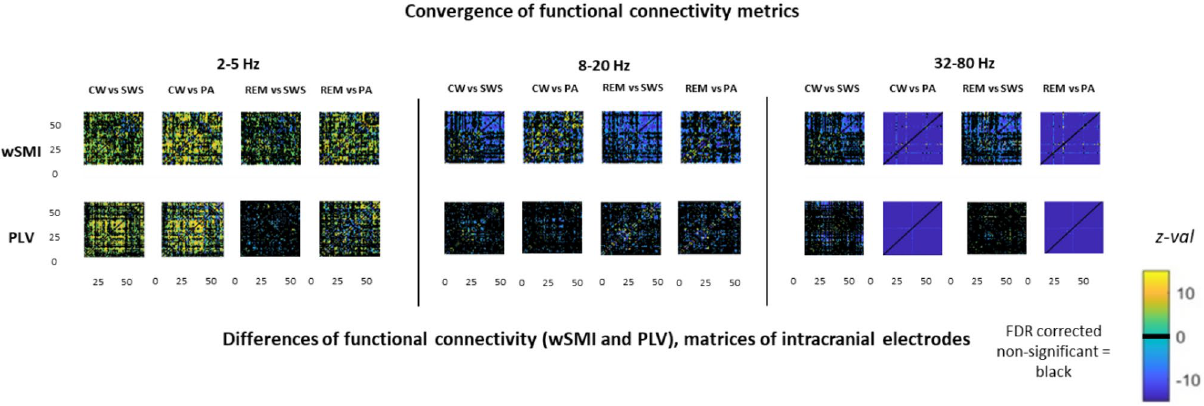
Figure 4. Example functional connectivity matrices estimated by wSMI and PLV (patient 1 of the second experiment). CW conscious wakefulness, SWS N3 slow wave sleep, REM rapid eye movement sleep, PA propofol induced general anaesthesia.